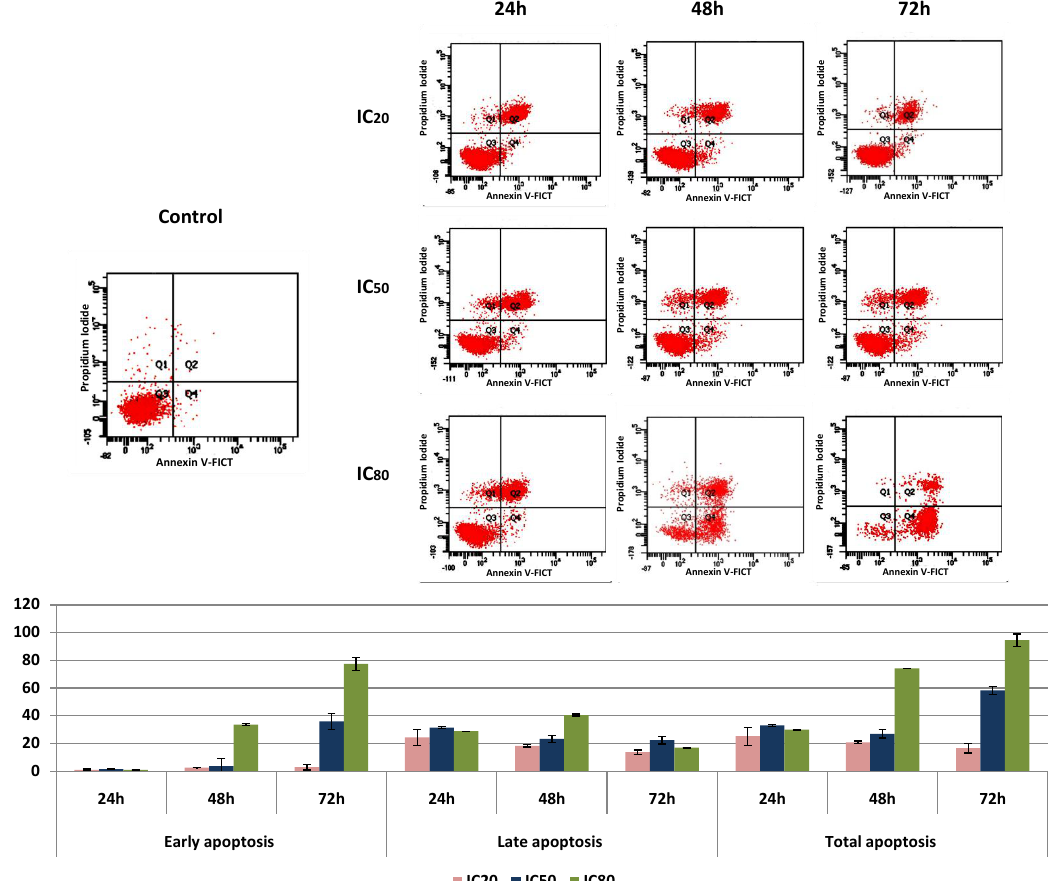
Figure 3. Flow cytometric analysis of Annexin V-FITC staining and propidium iodide (PI) accumulation after the exposure of HepG2 cells to OADP for 24, 48, and 72 h. The cell line was treated at concentrations equal to the IC 20 , IC 50 , and IC 80 values. Top: Diagrams of annexin V / PI flow cytometry. The right quadrants of each diagram represent apoptotic cells (Q2, late apoptosis; Q4, early apoptosis). Bottom: Flow cytometry analysis of Annexin V-FITC staining and PI accumulation. Values represent the mean S.E.M of duplicate independent experiments, performed in ±